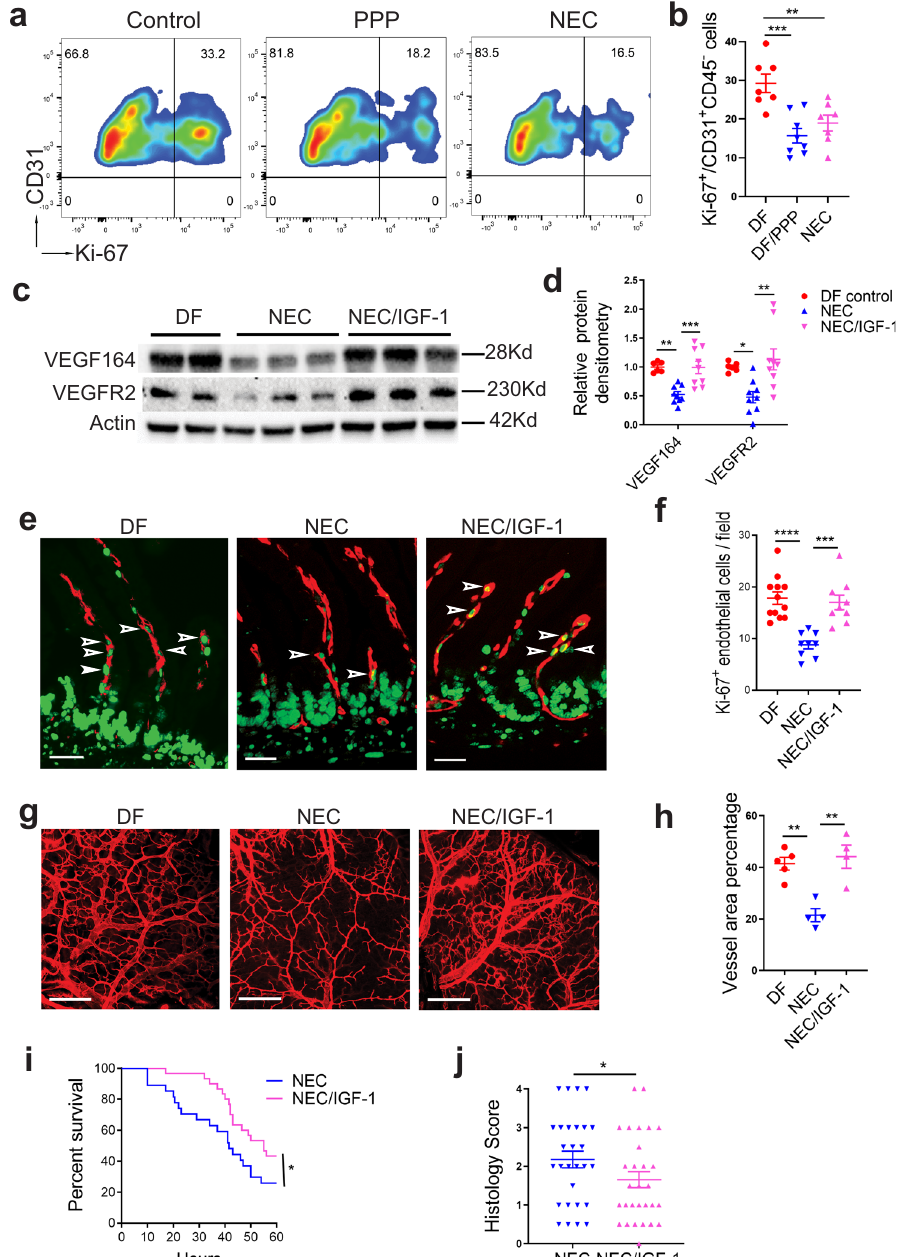
Fig. 7 Blocking IGF-1 signaling decreases intestinal endothelial cell proliferation in vivo; exogenous IGF-1 enhances VEGF protein expression, intestinal endothelial cell proliferation and preserves intestinal microvascular density during experimental NEC. a , b 24-hour-old wild-type C57BL/6 pups were treated with the IGF-1R inhibitor PPP ( n = 8) or vehicle control ( n = 7) or submitted to the NEC protocol for 24 h ( n = 7). Intestinal LP cells were isolated and the percentage of proliferating endothelial cells (Ki-67 + CD31 + CD45 − /CD31 + CD45 − ) was determined by fl ow cytometry. a Typical FACS plots are shown. b Graph represents the results of three experiments combined (mean± SEM). c – h 1-day-old neonatal mice were injected with IGF-1 (25 μ g/kg, i.p., twice) or vehicle control, with a fi rst dose 2 h prior to NEC initiation and a second dose 12 h later (Dam-fed littermates as controls) then submitted to experimental NEC for 24 h ( c – f ) or 48 h ( g , h ). c , d Intestinal tissues were assessed for VEGF and VEGFR2 proteins by western blot ( c ) and band densitometry is shown ( d , mean ± SEM), n = 6 – 9/group (see panel or Source Data fi le for exact n number). e , f Tissue sections were stained with Ab against Ki-67 and endomucin. e Typical immuno fl uorescence images. f Graph represents average proliferating endothelial cells (Ki-67 + endomucin + cells, arrows in e ) counted per ×20 fi eld (mean ± SEM, three fi elds were taken from each sample), n = 9 – 12/group (see Source Data fi le for exact n number). g , h pups were perfused intracardially with WGA-Alexa Fluor 647. Intestinal submucosal vascular networks were imaged, and vascular density was assessed using Photoshop (×10), n = 4 – 5/group (see dots in panel). P values were calculated using one-way ANOVA followed by Turkey – Kramer multiple- comparison test ( b , d , f , and h ). i , j Neonatal mice was submitted to the NEC model and treated with IGF-1 or control twice daily (see method section). i 60- hour-survival curve is shown ( n = 28 in NEC and 30 in NEC/IGF-1 group), P value were calculated using Gehan – Breslow – Wilcoxon test. j Intestinal injury histological scores ( n = 28 in NEC and 29 in NEC-IGF-1 group), P value were calculated using Chi-square test. * p < 0.05, ** p < 0.01, *** p < 0.001, **** p < 0.0001. Source data are provided as a Source Data fi